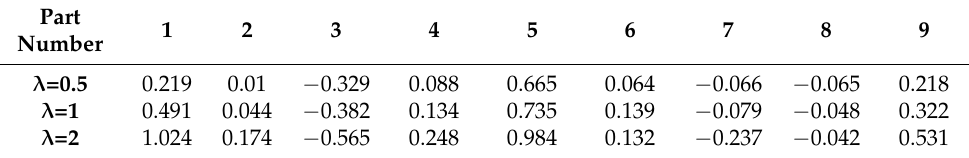
Table 1. Initial shear coefficients of the tunnel under different lateral pressure